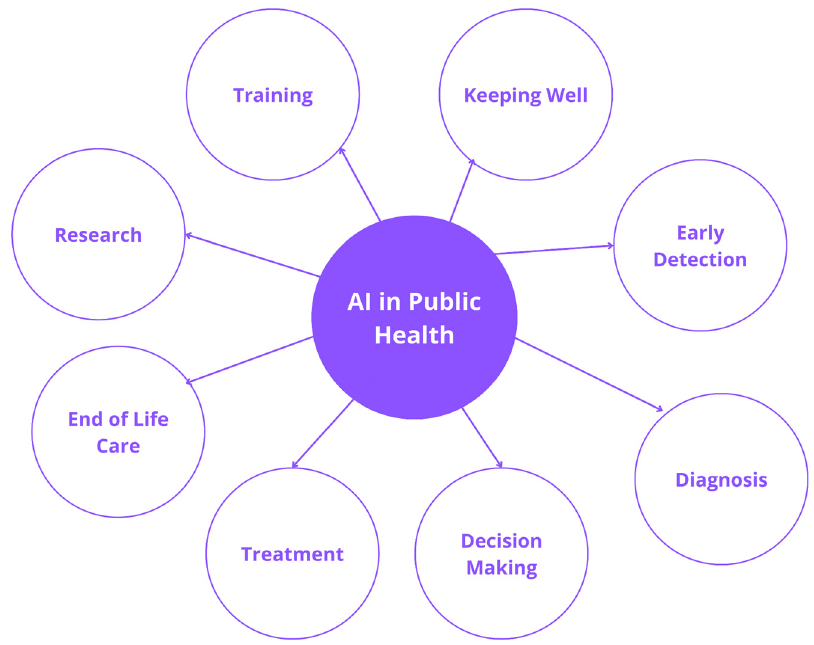
Figure 8. Utilities of AI in public health.